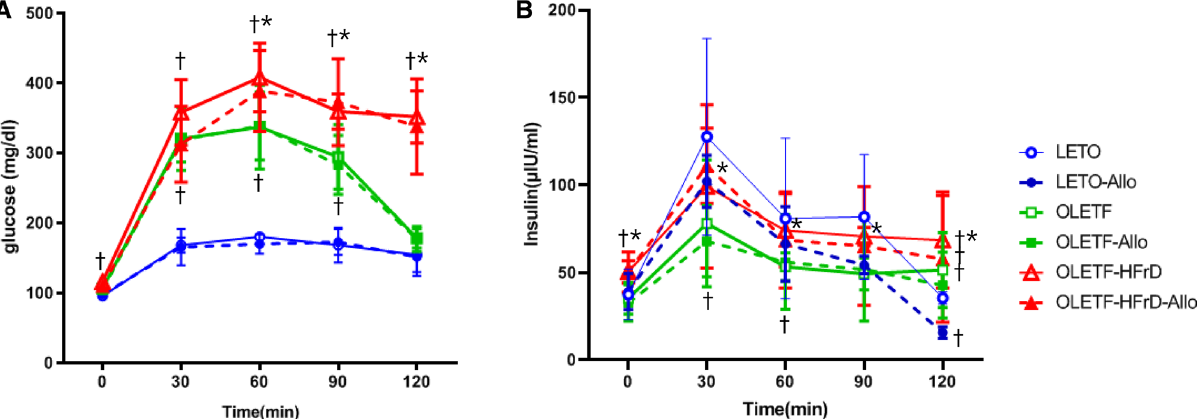
Figure 1. Effects of HFrD and allopurinol treatment on glucose tolerance test. ( A ) Glucose concentrations and ( B ) insulin concentrations in LETO, LETO-Allo, OLETF, OLETF-Allo, OLETF-HFrD, and OLETF-HFrD- Allo group during intraperitoneal glucose tolerance test (IPGTT). IPGTT were conducted. 2 g/kg glucose was intraperitoneally administered to rats after overnight fasting. And blood samples were collected for the measurement of biochemical parameters at 0 min, 30 min, 60 min, 90 min, and 120 min after glucose injection. Data are expressed as mean ± SE. † P < 0.05, versus the LETO group. * P < 0.05, versus OLETF group. LETO, Long-Evans Tohushima Otsuka; LETO-Allo, LETO rats treated with allopurinol; OLETF, Otsuka Long-Evans Tokushima Fatty rats; OLETF-Allo, OLETF rats treated with allopurinol; OLETF-HFrD, OLETF rats fed a high fructose diet; OLETF-HFrD-Allo rats, OLETF rats fed a high fructose diet treated with